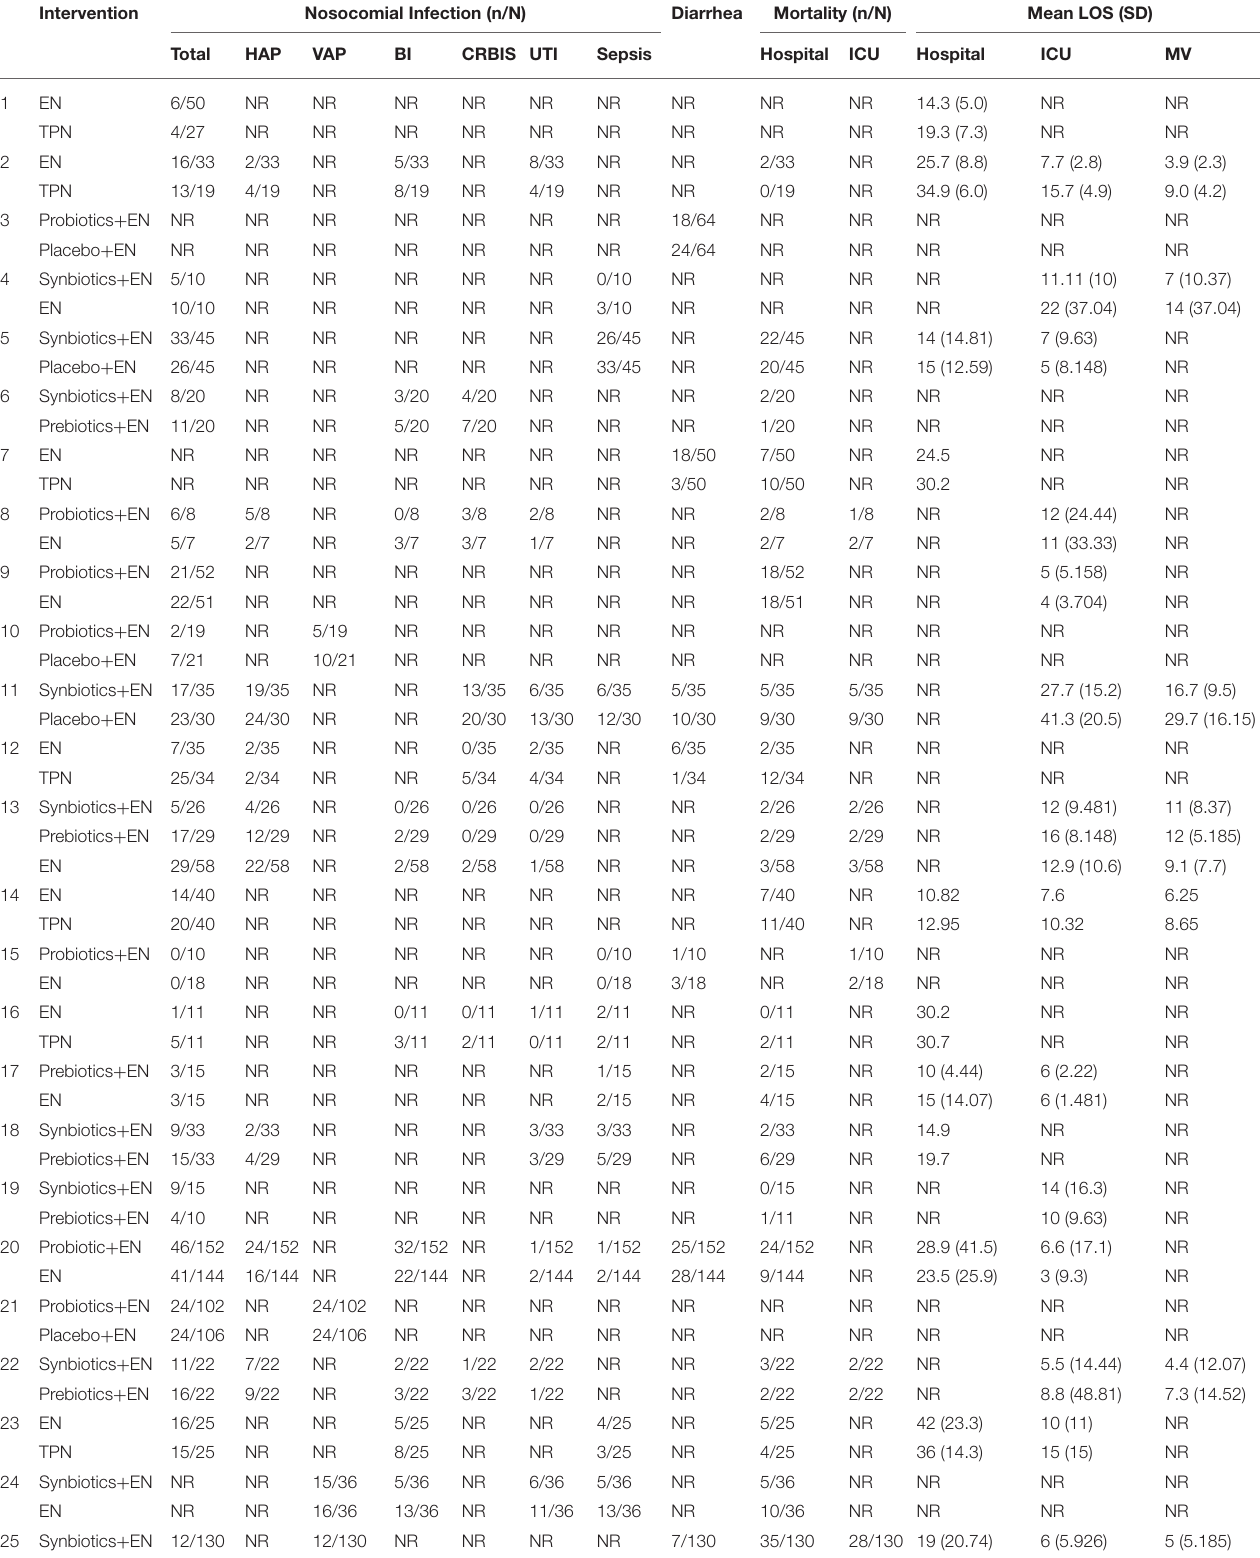
TABLE 3 | Reported clinical outcomes of included studies. Intervention Nosocomial Infection (n/N) Diarrhea Mortality